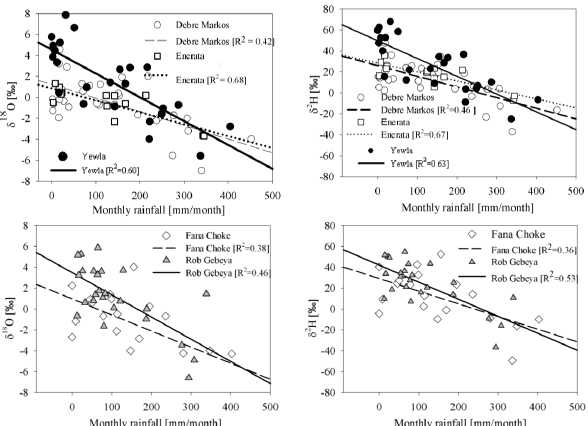
Figure 7. Relationship between amount-weighted isotopic compo- Fig. 7. Relationship between amount weighted isotopic composition of precipitation samples sition of precipitation samples at different stations with monthly at different stations with monthly precipitation amounts at respective stations during the precipitation amounts at respective stations during the investigation investigation period.